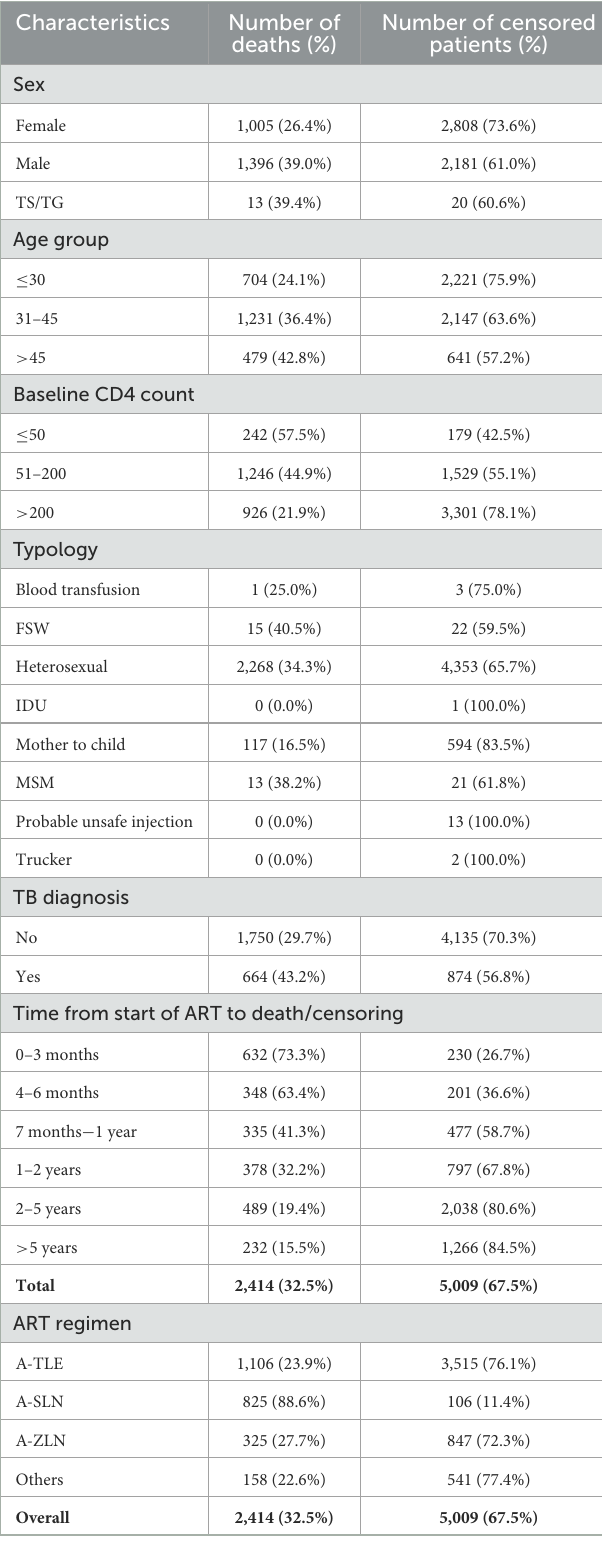
TABLE 2 Comparison of demographic and clinical characteristics according to deaths and censored patients.